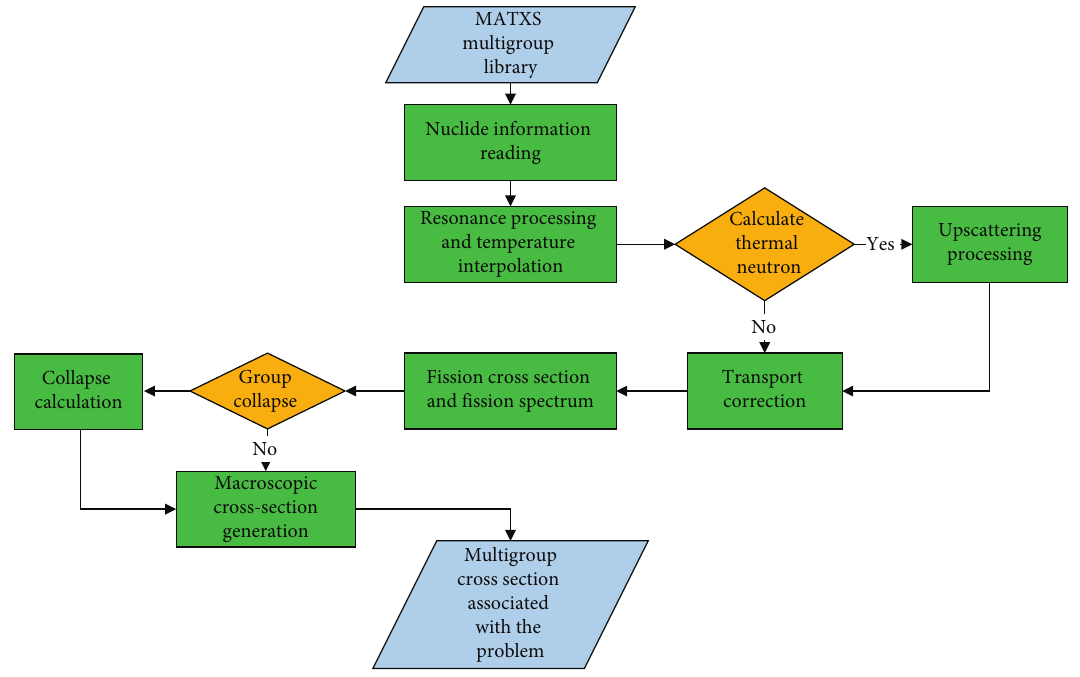
Figure 1: Processing procedure of ARES-MACXS.